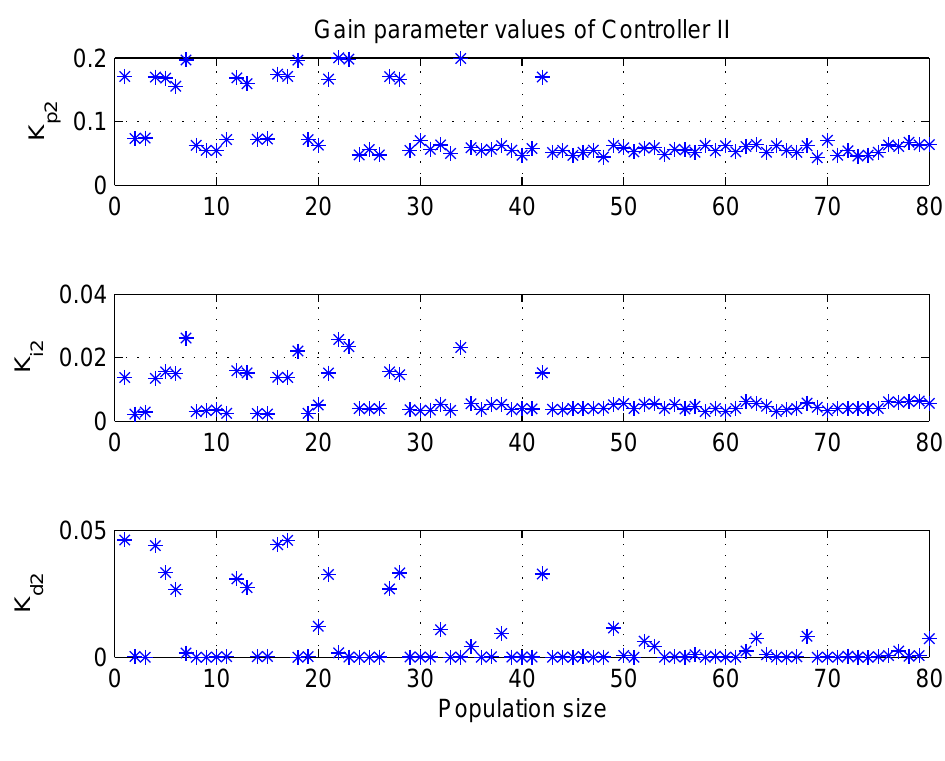
Figure 8. PID gain parameters of 2 th loop at each